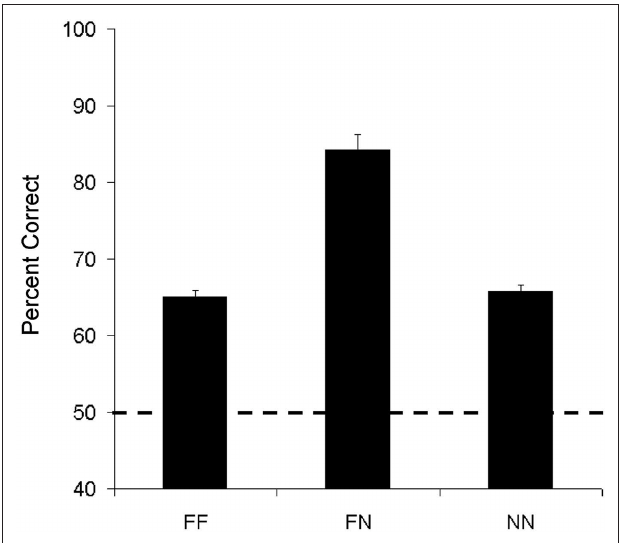
Figure 5 | Average accuracy for experiment 2A across each of the three stimulus control classes. Error bars reflect the SEM and the dotted line indicates chance for the